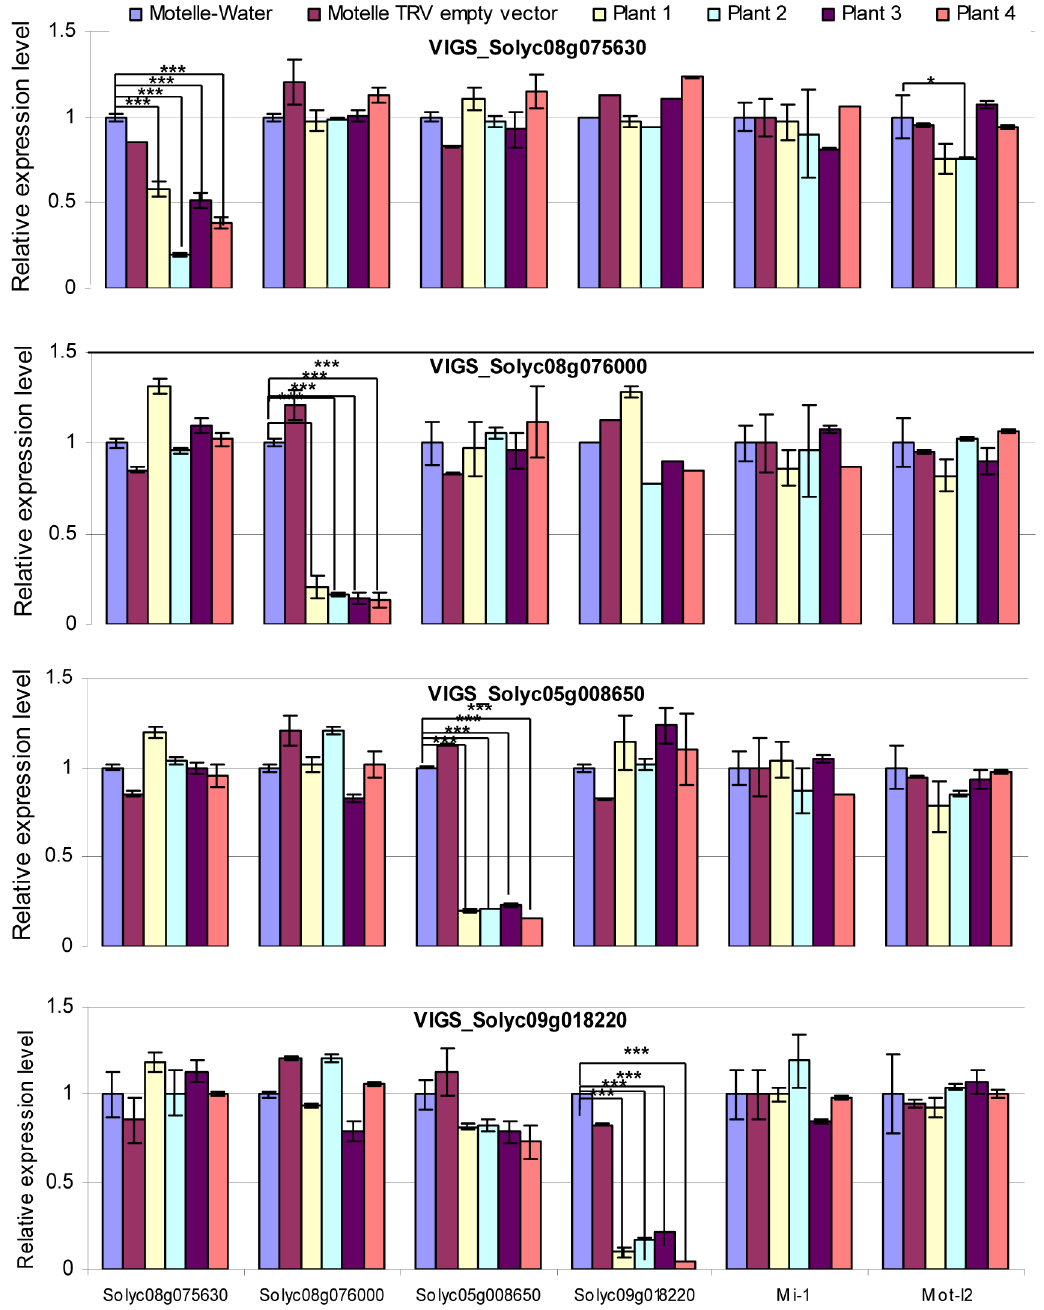
Figure 6. qRT-PCR to assess the degree of gene silencing and to determine possible off-target effects in VIGS plants. Leaflets were harvested four weeks after VIGS and prior to infection with F. oxysporum . Total RNA was isolated and subjected to qRT-PCR to evaluate expression of the four predicted miRNA target genes, along with Mi-1 and Mot- I-2 controls. The silenced gene is indicated in the title for each horizontal panel, while the gene transcript being measured is shown under the y-axis at the bottom of the figure. Plants treated with water or the TRV empty vector are included as negative controls. mRNA levels are expressed relative to the Motelle plant not treated with TRV for each VIGS construct. Values were normalized using tomato 18S rRNA. Errors are expressed as the standard error. Significant differences are indicated by asterisks. Among all of the VIGS plants, only VIGS Solyc08g075630 Plant # 2 exhibits evidence of an off-target reduction in Mot- I-2 transcript levels relative to the water-treated control. * and *** indicate significant differences when compared to the corresponding control plants in the same treatments at p , 0.05 and p , 0.001, respectively. Due to extensive DNA sequence homology with another gene However, this construct resulted in susceptibility of the Motelle (Solyc02g014230), we were not able to produce a VIGS construct cultivar to F. oxysporum infection, and accumulation of fungal that was specific for the slmiR482f target Solyc08g076000. biomass comparable to that observed during knockdown of the